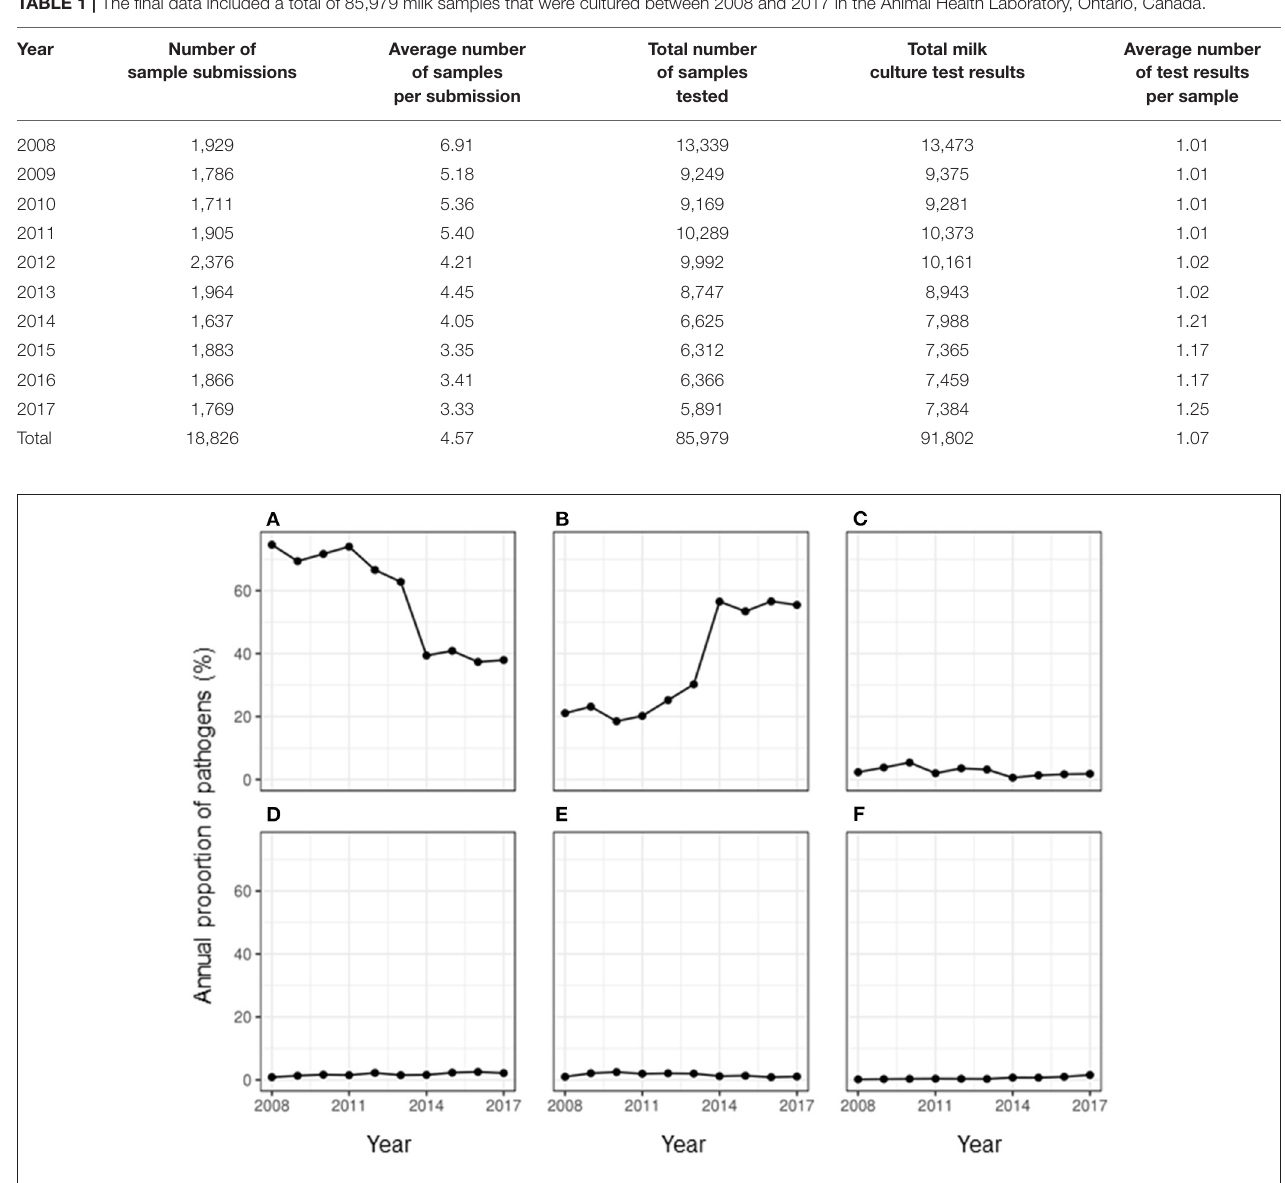
FIGURE 1 | Annual proportion of the major classes of pathogens isolated from milk samples submitted to the University of Guelph, Animal Health Laboratory, Ontario, Canada between 2008 and 2017. (A) No growth, (B) bacteria, (C) contamination, (D) algae, (E) fungus, and (F) mixed growth.